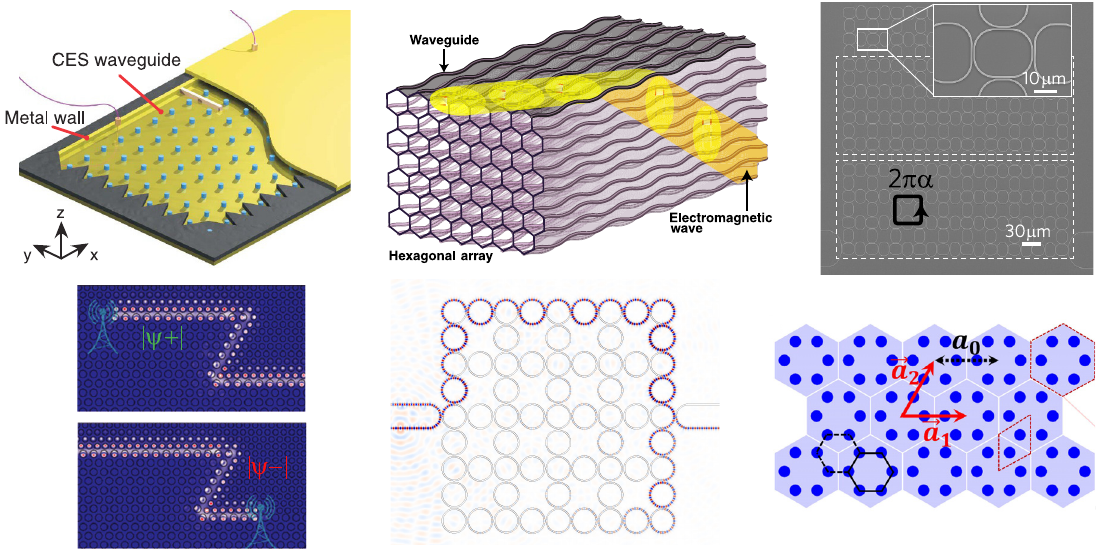
Figure 2: Various schemes for realizing topological insulators for electromagnetic (EM) waves. Top, left to right: two-dimensional (2D) photonic crystal incorporating gyro-optic materials realizing the quantum Hall effect [8]; honeycomb lattice of helical waveguides realizing Floquet topological insulators [12, 22], aperiodic resonator array realizing the quantum Hall effect [10, 15]. Bottom, left to right: photonic topological insulator based on bianisotropic materials [11, 17], the network model of photonic topological insulators [18, 19], the crystalline photonic topological insulators [20,